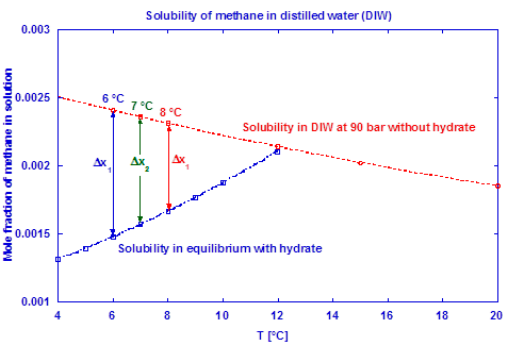
Figure 4. Mole fraction of methane dissolved in water as a function of temperature in systems with and without methane hydrate present.